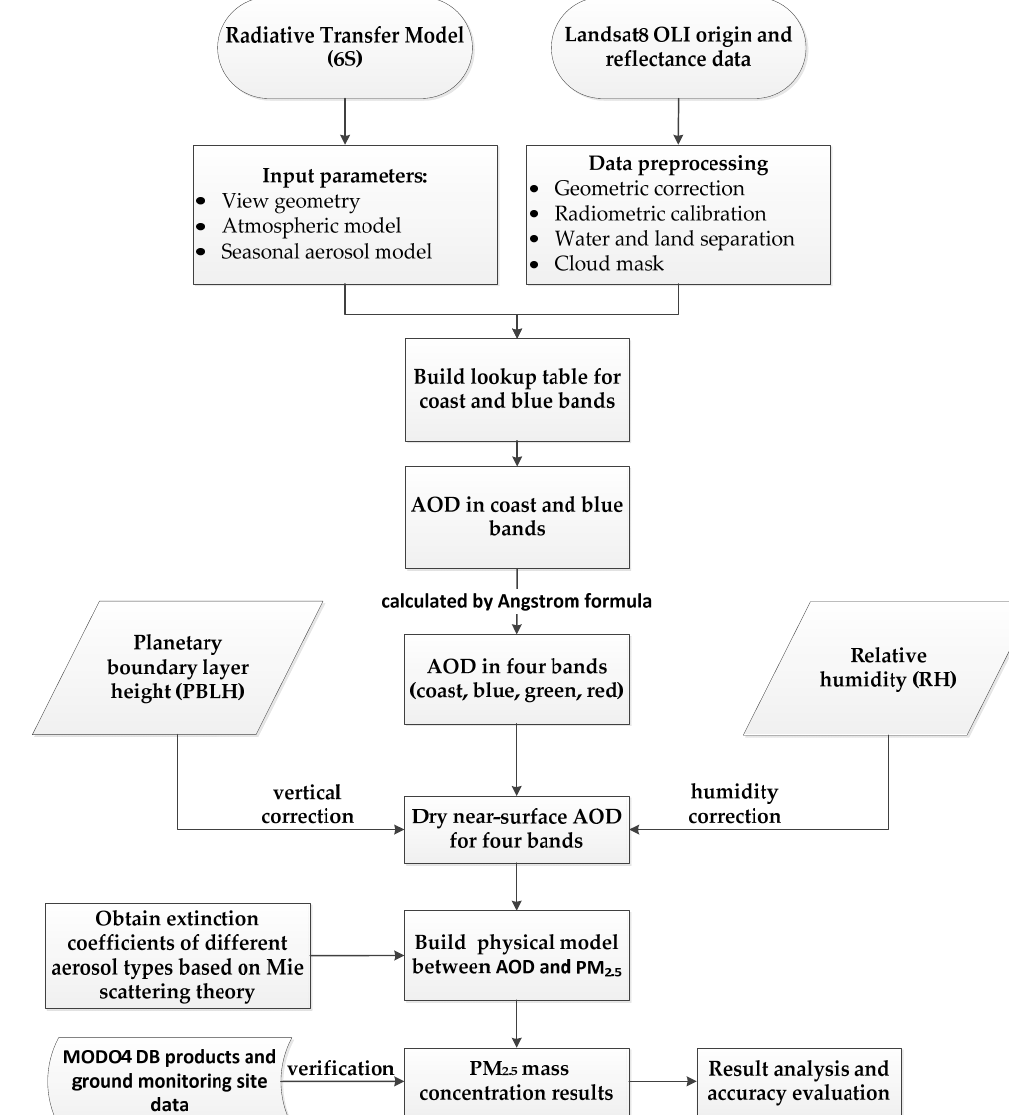
Figure 2. Technical flow chart of PM 2.5 mass concentration estimation.